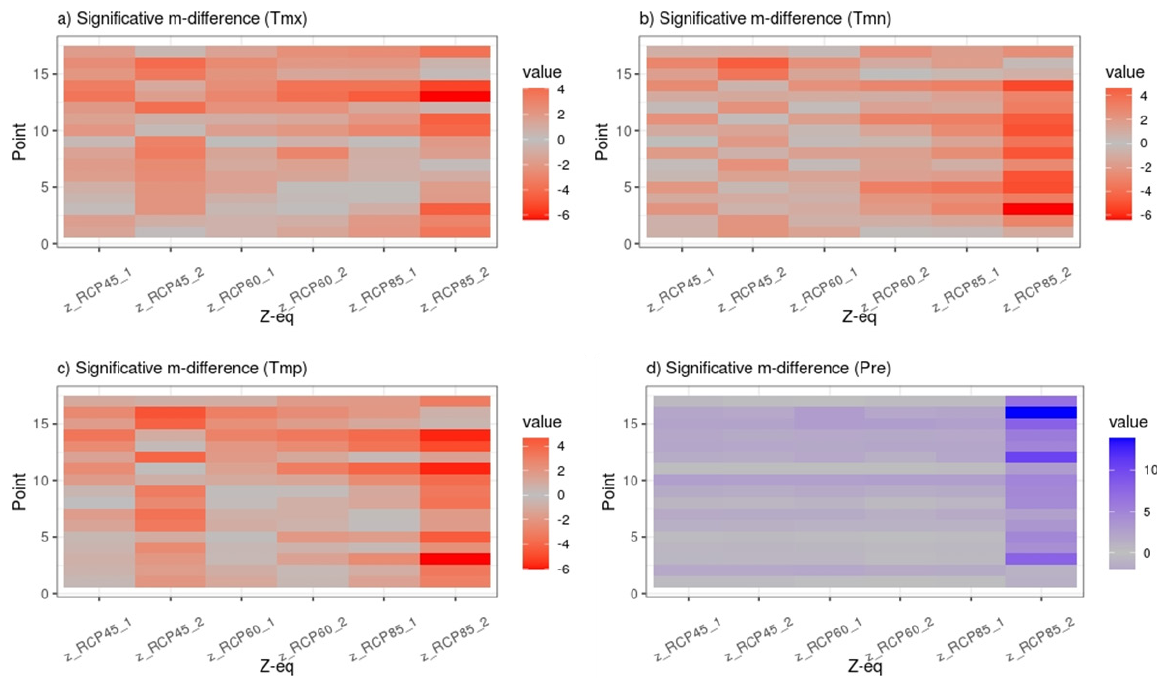
Figure 5. Plots of z-eq for the four variables, ( a ) Tmx, ( b ) Tmn, ( c ) Tmp, and ( d ) Pre, in each study point and for each RCP scenario. The significant difference between the trends (historic and projected) is shown by the dark colors (red and blue). In addition, the CRU and RCP data cover two years: 2015 and 2016. In this case, we have compared this year’s anomalies for both data. The historical anomalies do not match the RCPs results: there is a difference of the 0.4 °C for Tmp, which is lower with RCPs (i.e., the RCPs underestimate the warming record). This behavior is similar to Tmx. However, for Tmn, the underestimation is between 0.1 °C and 0.3 °C. For Pre, the main difference is in the sense of the anomalies’ change between historical and RCPs. In Mexico, Tmp is the variable with better performance for RCPs with CRU in 2015. This is also the case for Tmx in 2016, followed by Tmn. For Pre, there is only one point with correspondence, which is point 1. CA has more points with correspondence between RCPs and CRU for both years. RCP 4.5 is the scenario that has more results in agreement. This scenario has a lower radiative force than the three RCPs. This suggests that in these years, starting in the near future, the climate change effects correspond to low GHG emissions. These results reveal which scenario is more ad-hoc in these two years, and also highlight where these three scenarios have similar behavior throughout the radiative forcing. 4. Discussion 4.1. Historical Trends The main results of the present study show that throughout the 57 years from 1960 to 2016, all 17 points of the region (SM-YP, CA and the Caribbean) have the same warming (~0.01 °C/year) in terms of temperature anomaly trends. The study of [31] reported an increase in warm events for the Caribbean. In the SM-YP region, this result is in agreement with other studies [11,13,73]. For example, [73] report that the warming trend for the southeast of Mexico is 0.1 (°C/decade) over a short period, from 1980 to 2010. Among all selected points in the study region, there are three points with notable discrepancies: one is at Panama and the other in Haiti and Jamaica (points 6, 14 and 16 in Table 3, respectively). Several studies performed over SM-YP, CA and the Caribbean region have already reported a persistent warming trend over this area [13,73,79–81]. The results